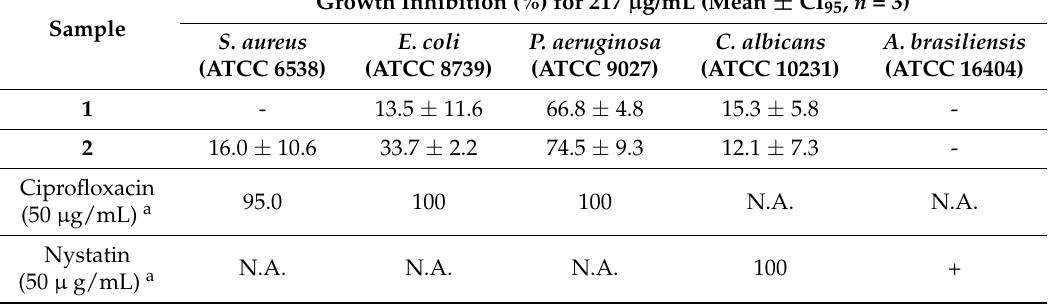
Table 3. Antimicrobial activity of the essential oil from the leaves of A. schaueriana collected at Estaç ã